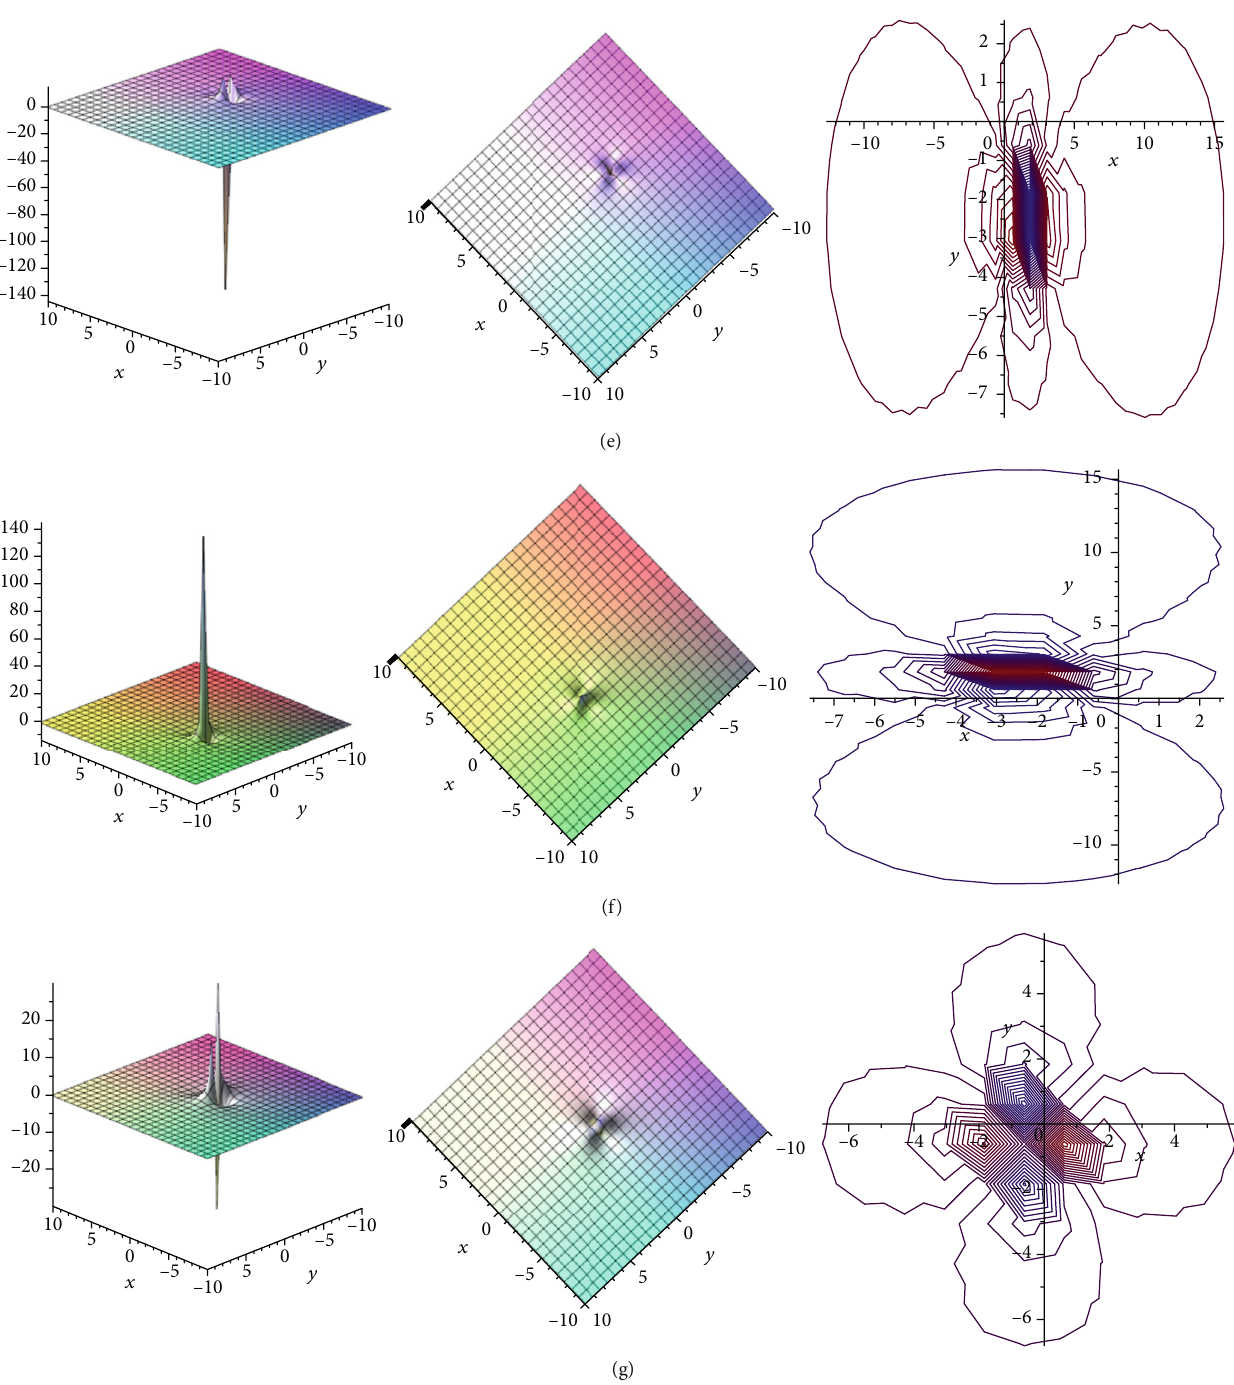
Figure 2: 3D plots and contour plots of equation (24) by choosing a = 2, b = 2, C